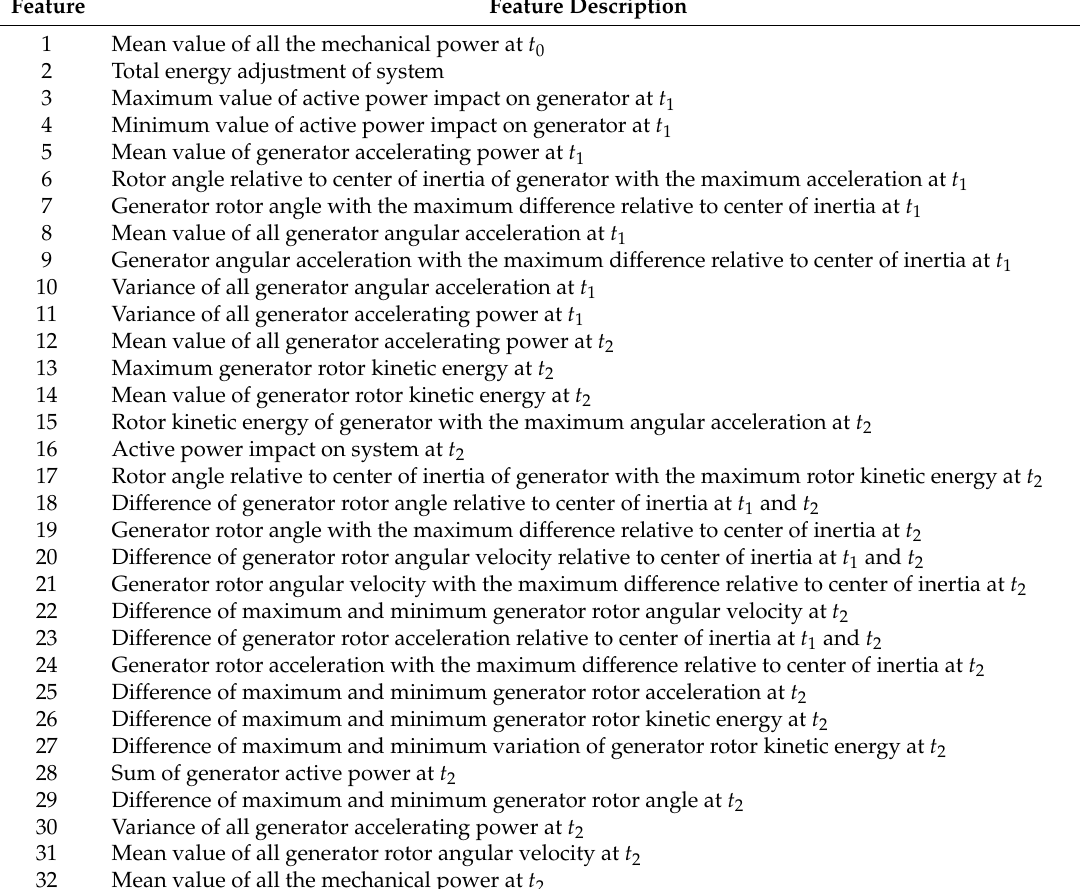
Table 1. The initial feature